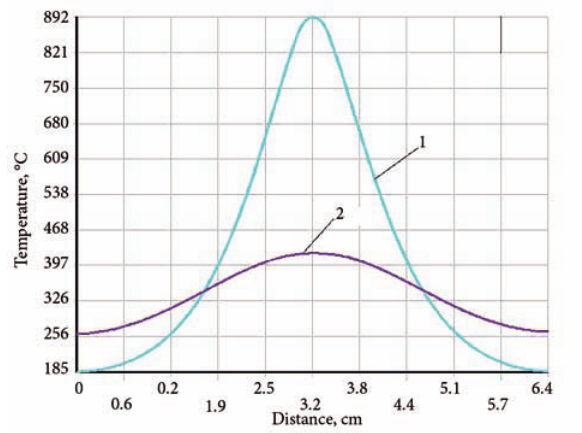
Fig. 9. Distribution of temperatures on control points: 1 – 10 s after welding; 2 – 20 s after welding